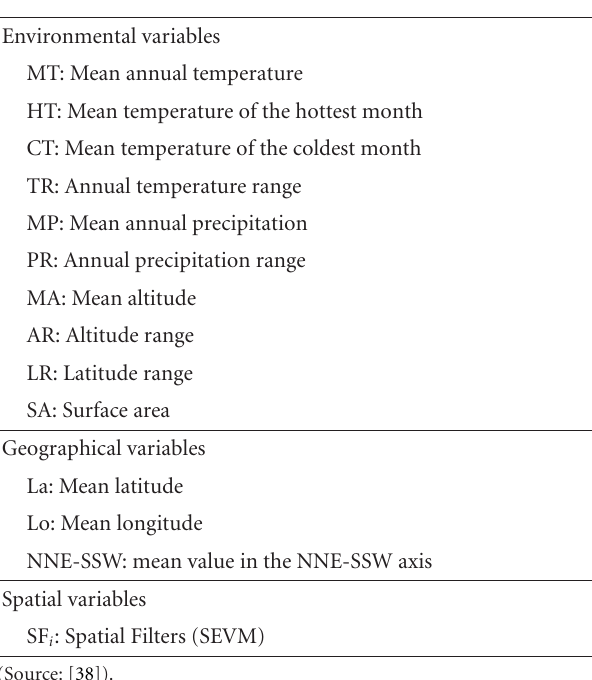
Table 1: Environmental, geographical, and spatial variables used for analysing the geographical gradients in terrestrial mammal species richness in the Argentinean provinces. SEVM: Spatial eigen- vector mapping.